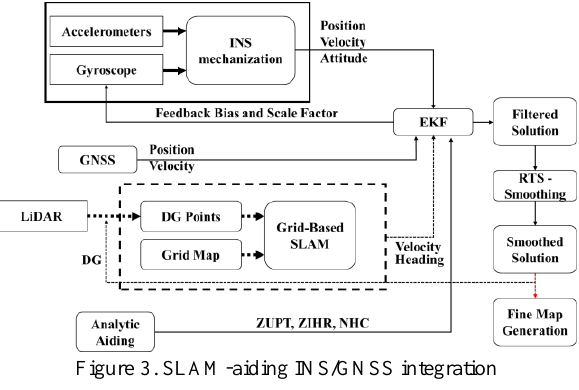
Figure 3. SLAM-aiding INS/GNSS integration